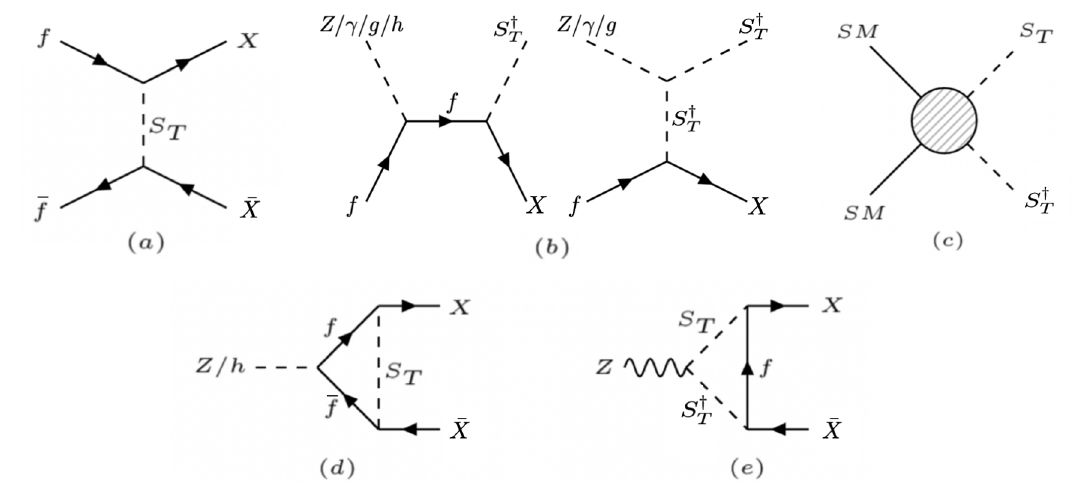
Figure 9 . Various contributions to dark matter freeze-in in the t-channel mediator scenario. Diagram (c) is representative of several processes involving SM particles annihilating into a pair of